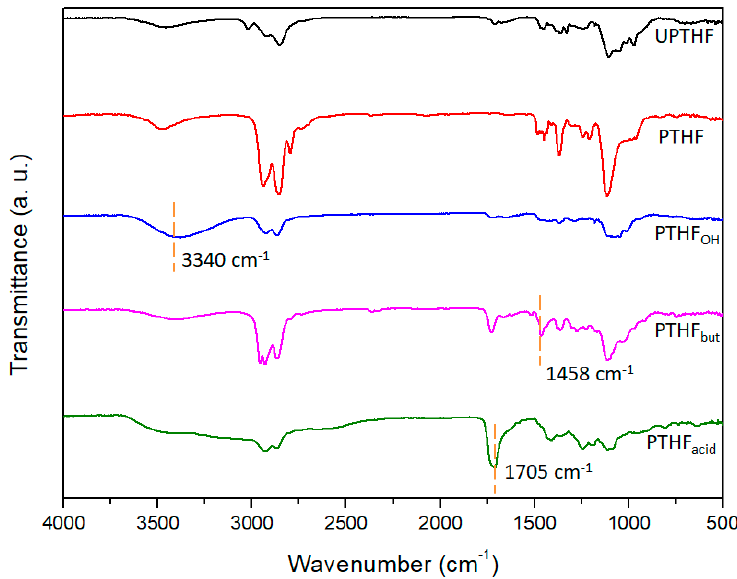
Figure 3. FTIR spectra of UPTHF, PTHF, PTHF OH , PTHF but and PTHF acid .